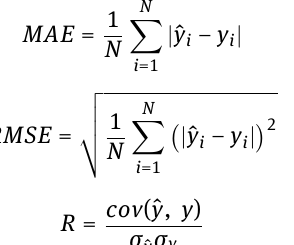
In order to measure the performance of the proposed method, the following three indexes are compared: RMSE (root mean square error), MAE (mean absolute error) and correlation coefficient R . The three indicators are defined as follows: